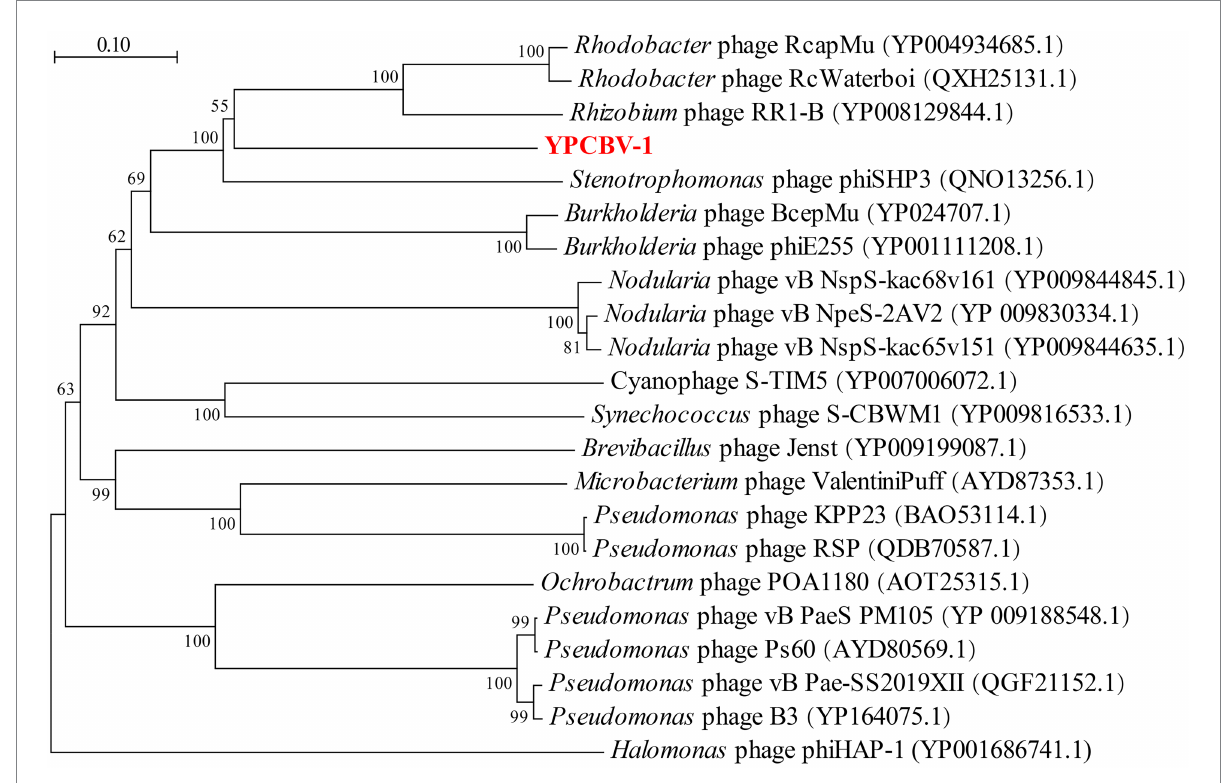
FIGURE 5 Major capsid protein phylogenetic tree. Phylogenetic trees were constructed using the neighbor-joining method by Mega 7.0. All parameters are default except the Bootstrap value is 1,000, the p-distance model is used to calculate the distance, and the Gap/Missing Data Treatment cutoff of 50%. Phage phiHAP-1 was selected as